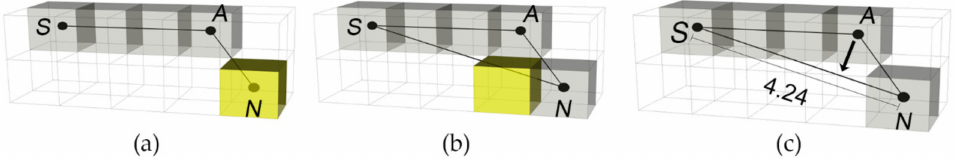
Figure 4. If ( a ) neither the current min-cost voxel propagates into a voxel with di ff erent friction nor ( b ) the source voxel of the min-cost voxel is blocked by a di ff erent friction voxel, then ( c ) the algorithm adjusts the travel path and